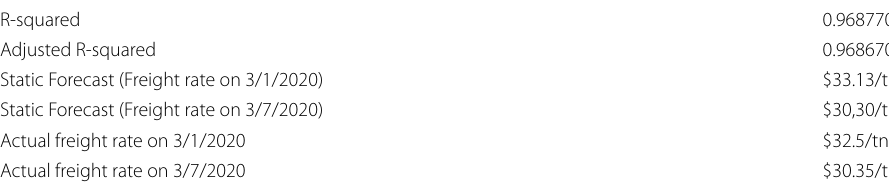
Table 3 Santos–Qingdao grains. Source : Elaboration by the authors R-squared 0.968770 Adjusted R-squared